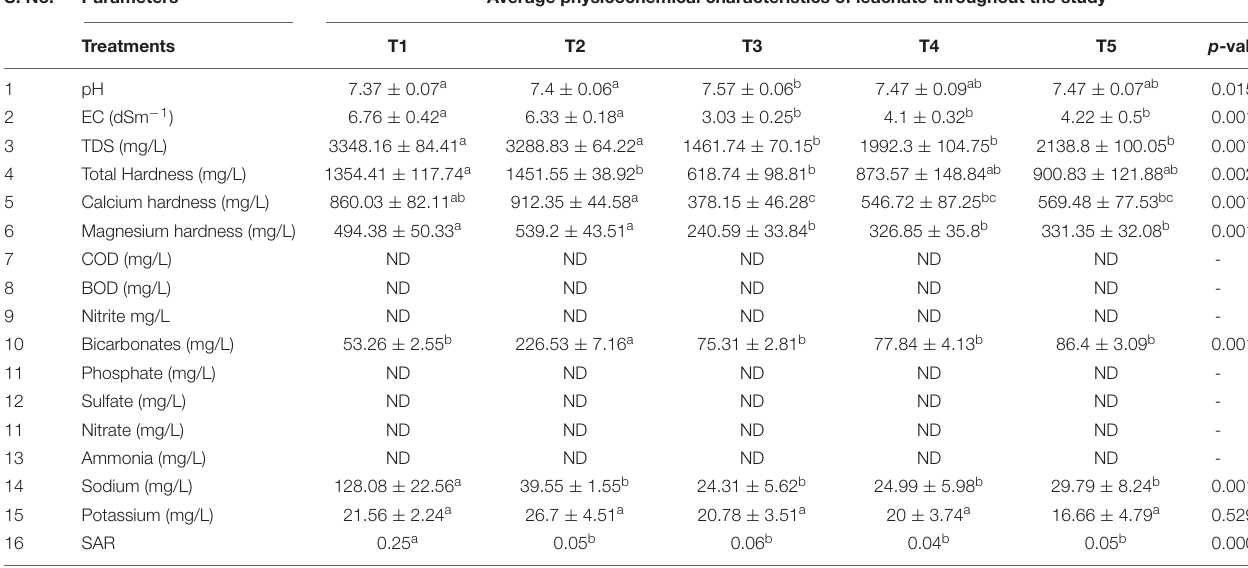
TABLE 5 | Average values of physicochemical characteristics of the leachates throughout the